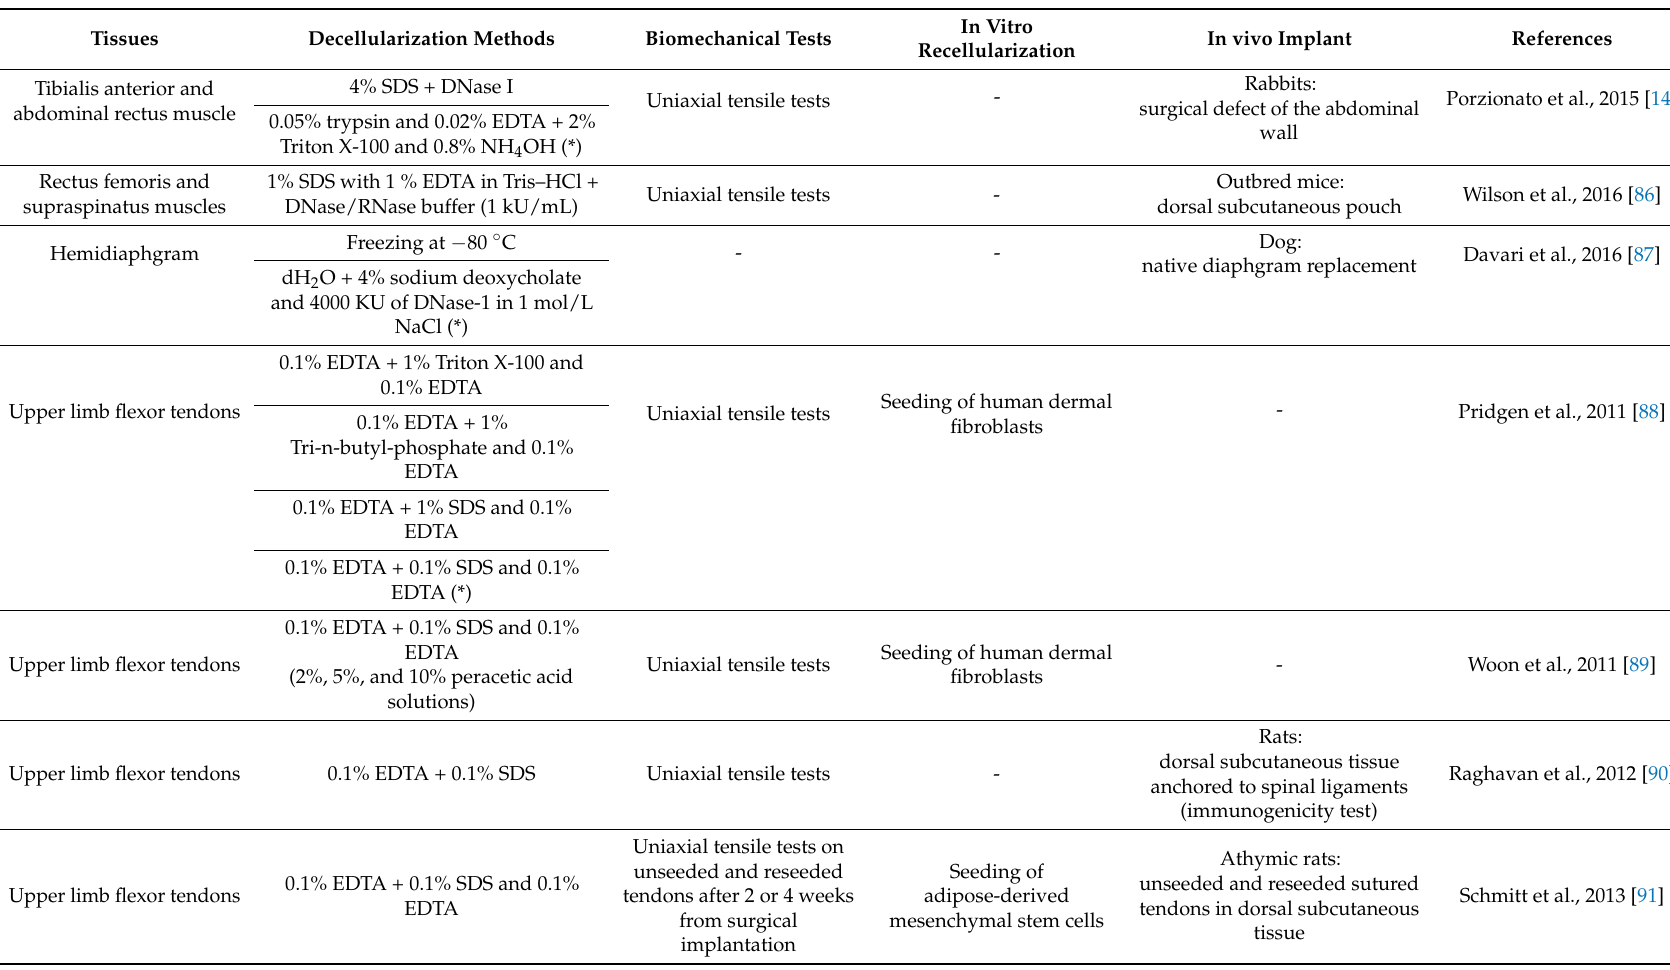
Table 2. Skeletal muscle and tendons. Decellularization techniques, biomechanical tests, recellularization methods, and in vivo implant of human muscular and tendinous extracellular